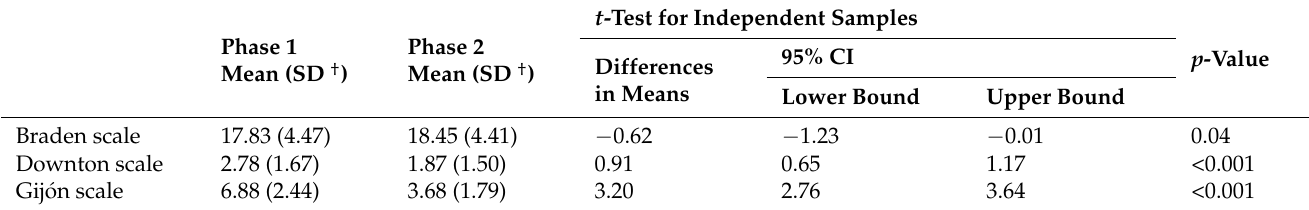
Table 3. Mean scores for the Braden, Downton, and Gij ó n scales between study phases 1 and 2.